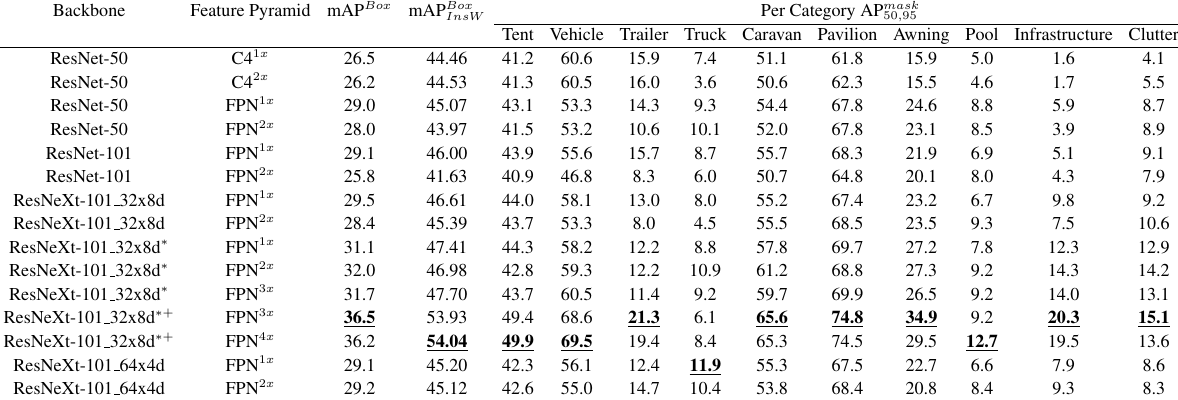
Table 2. Comparison of the baselines for instance segmentation. (+) Trained with augmented training data. (*) augmented testing. Backbone